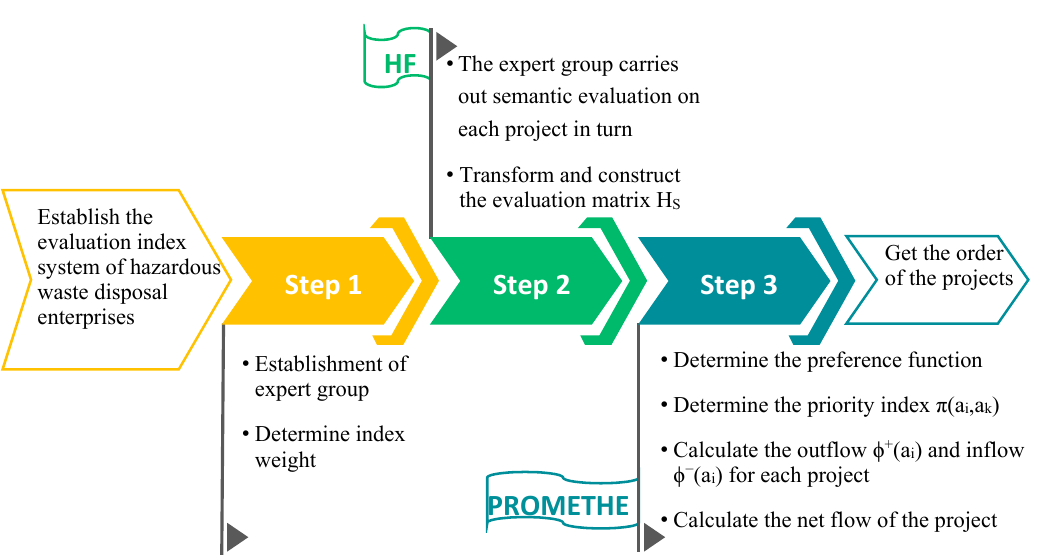
Figure 2. Logical structure for the hesitant fuzzy linguistic (HFL)-PROMETHEE model. Table 1. Hazardous waste disposal enterprise selection evaluation index